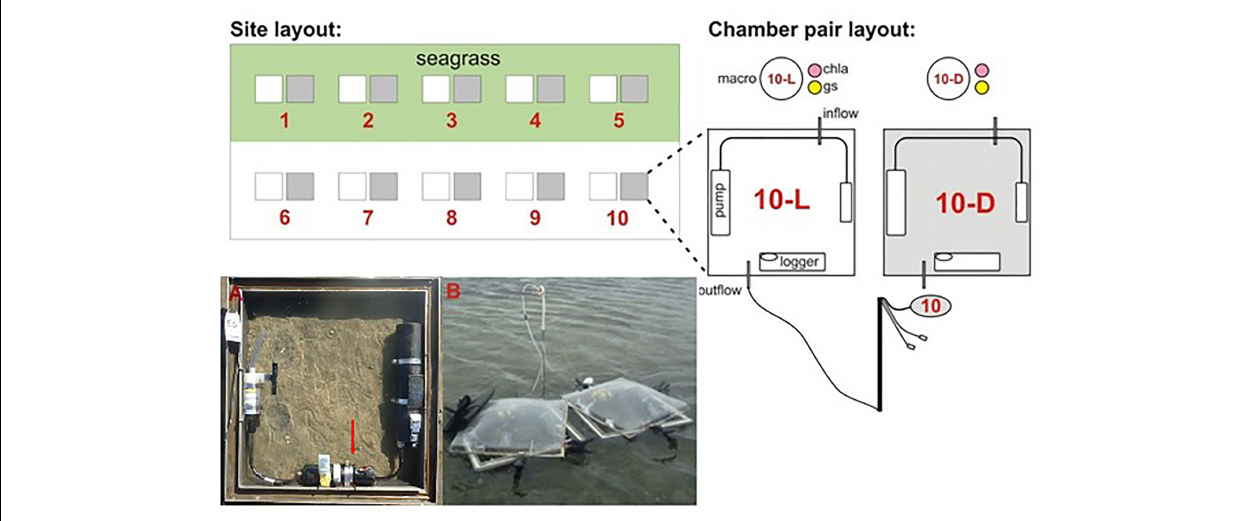
FIGURE 1 | Description of field work site and chamber layout. (A) A light chamber, deployed, with dissolved oxygen logger and water stirring system under a clear Perspex dome, (B) the field site, pre-deployment, just prior to being fully immersed by the incoming tide. Chla, chlorophyll a; gs, grain size; macro, macrofaunal